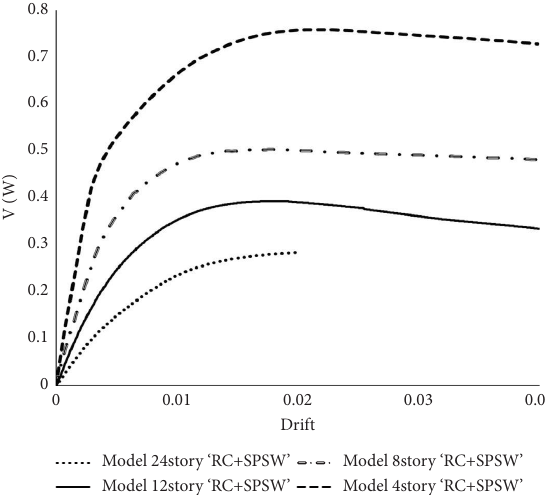
Figure 4: Result of nonlinear static analysis of models.